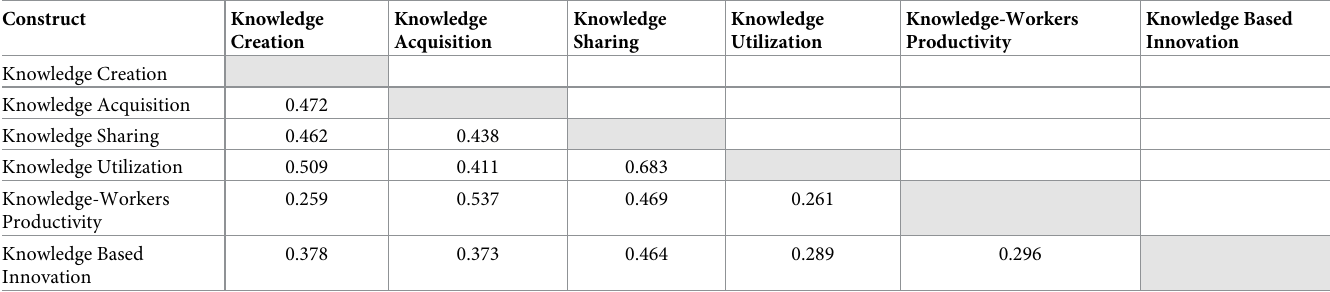
Table 4. Heterotrait-Monotrait Ration